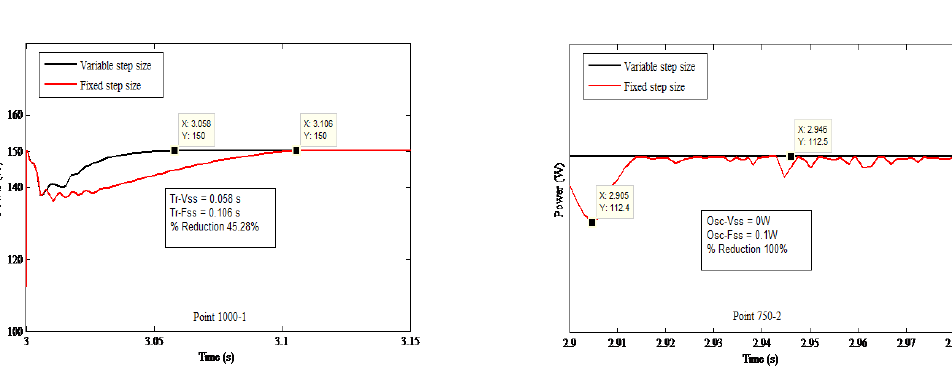
Fig. 11: Output power: Zoom in Point 600-2.